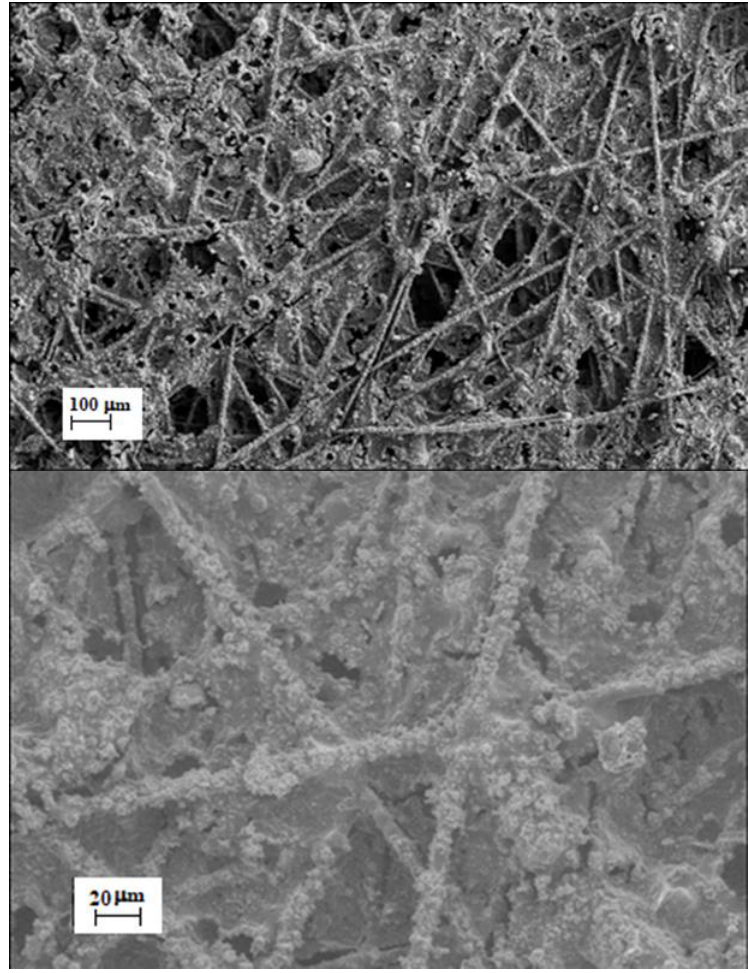
Figure 14. SEM micrographs with a different magnification of PSU-TMA + PANI + GAH-Oct fibers. X-ray diffractograms were recorded using a Bruker D5000 diffractometer with Cu K α radiation ( λ = 0.15406 nm, 38 kV, 30 mA), 0.04° steps, and 2 s step time.